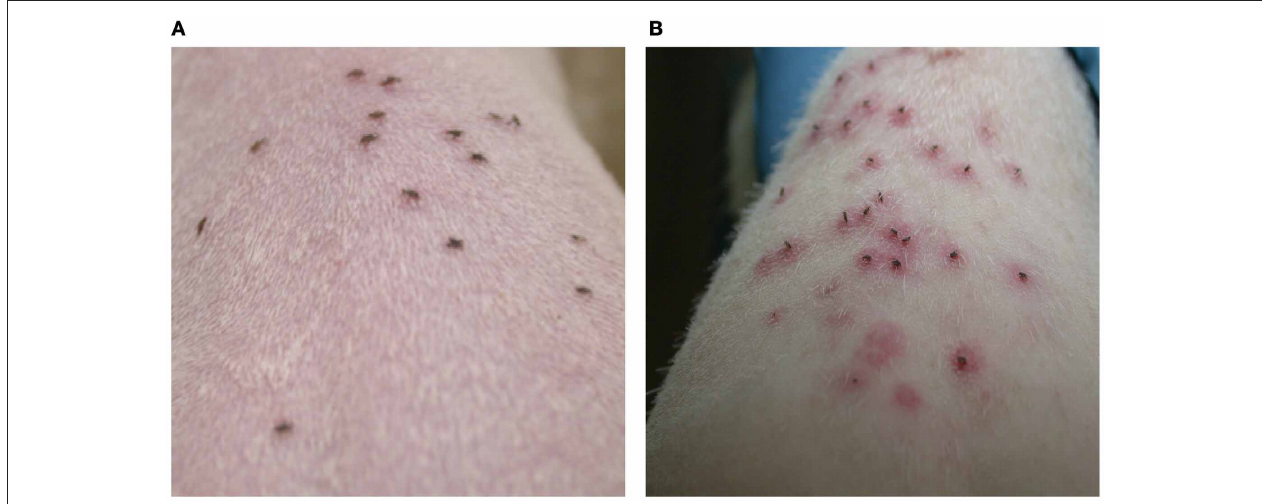
FIGURE 2 | Ixodesscapularis infestationsofguineapigsresultsinthedevelopmentofacquiredresistancetoticks. Nymphsfeedingon: (A) naïveguineapig showsnorednessat thetickbite-sitesand (B) repeatedlytick-infestedguineapigshowsincreasedrednessaroundthetickbite-sitewithin 24h oftick attachment.